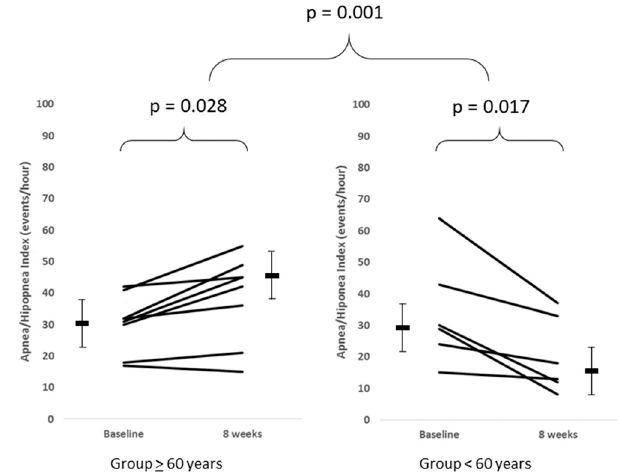
Figure 2. The apnea-hypopnea index before (i.e., baseline) and after a comprehensive eight-week protocol in patients with obstructive sleep apnea. Intragroup comparison before and after using a Wilcoxon test for skewness distribution. Intergroup comparisons for differences between variables were assessed using the Mann-Whitney test for skewness distribution.